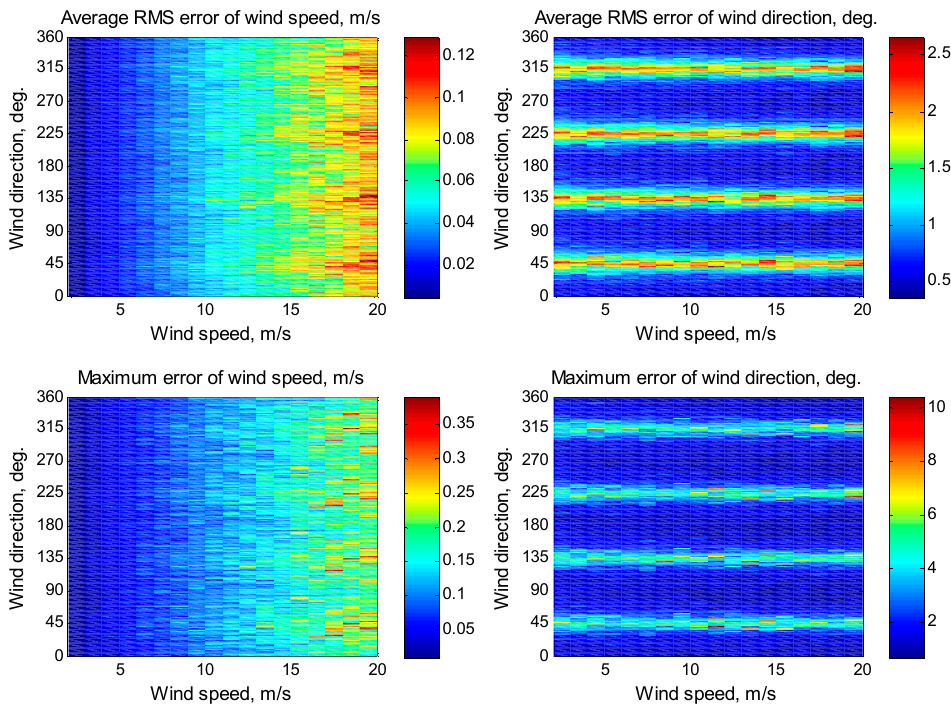
Figure 3. Simulation results for the mounting angle of a beam axis in the horizontal plane of 45° without instrumental noise at the wind speeds of 2–20 m/s for the incidence angle of 30° with 5000 averaged NRCS samples for each azimuthal angle.